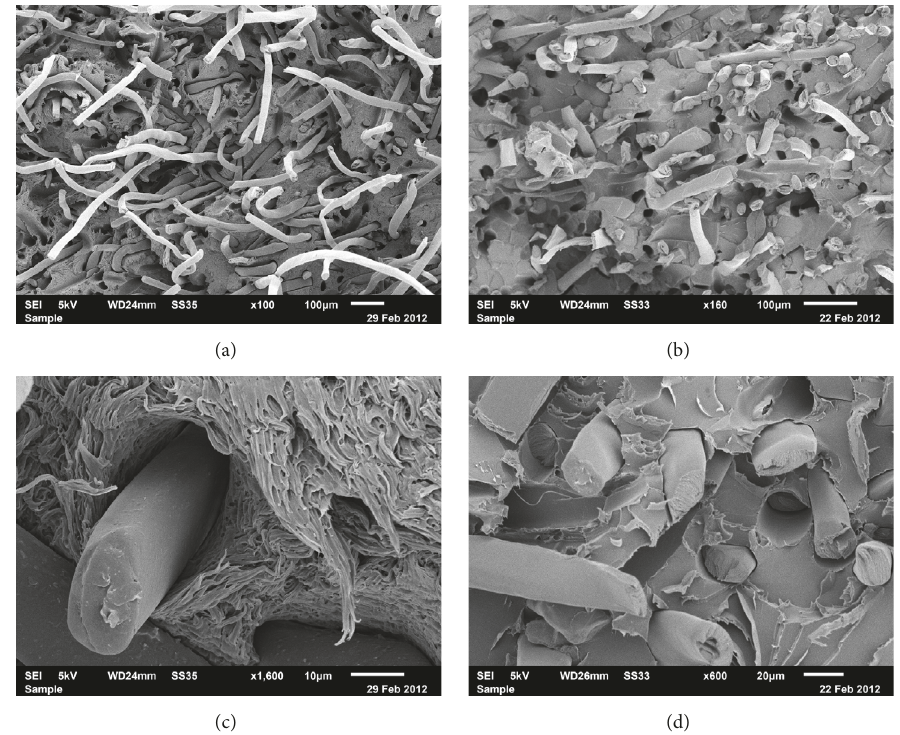
Figure 5: SEM micrographs of tensile fracture surfaces of IM lyocell/PP (a and c) and IM lyocell/PLA (b and